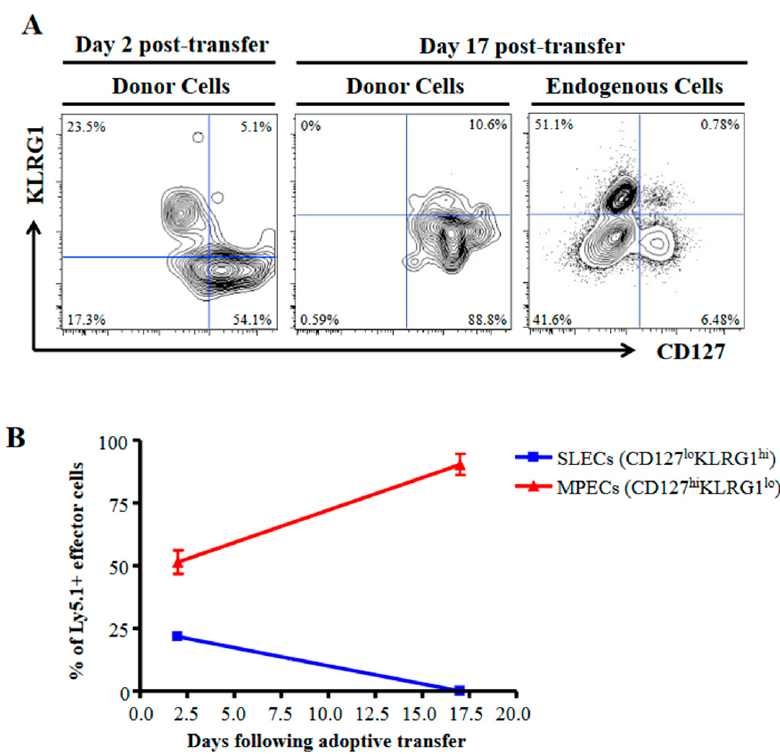
Figure 2. MPECs and SLECs generated in vitro possess characteristic persistence properties in vivo. ( A , B ) Congenically marked (Ly5.1+) polyclonal CD8 T cells were stimulated with anti-CD3 ε and anti-CD28 mAbs for 5 days prior to transfer into B6 (Ly5.2+) mice. The persistence of donor MPECs and SLECs was followed by a blood draw (at days 2 and 17) and splenocyte harvest (at day 17) until SLECs were no longer detectable. The donor cells constitute 3–5% of the total in the recipient mice. Representative flow plots ( A ) and the mean percentage of MPECs (red line) and SLECs (blue line) across time ( B ) are shown. Both donor and endogenous cells are gated on effector CD8 T cells. Error bars represent the standard deviation.